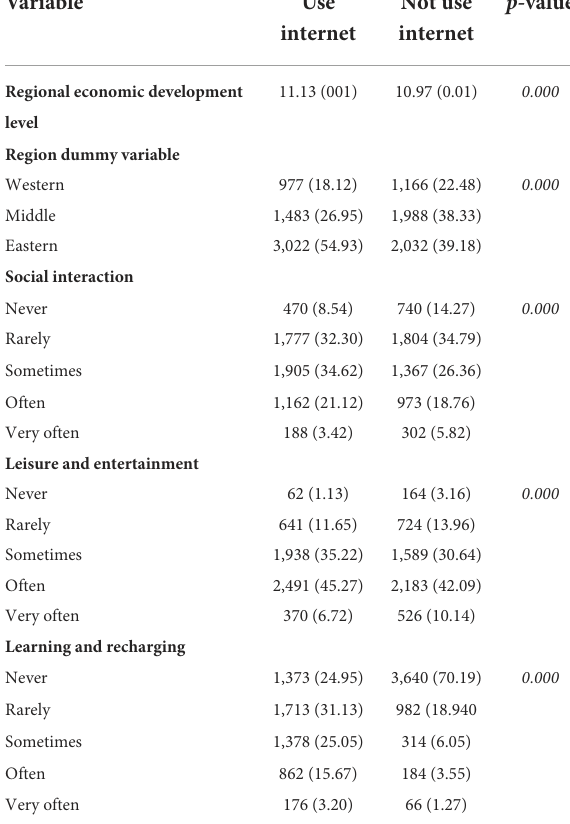
TABLE 1 Variable names, variable definitions, and descriptive statistics [mean (SD)/ n